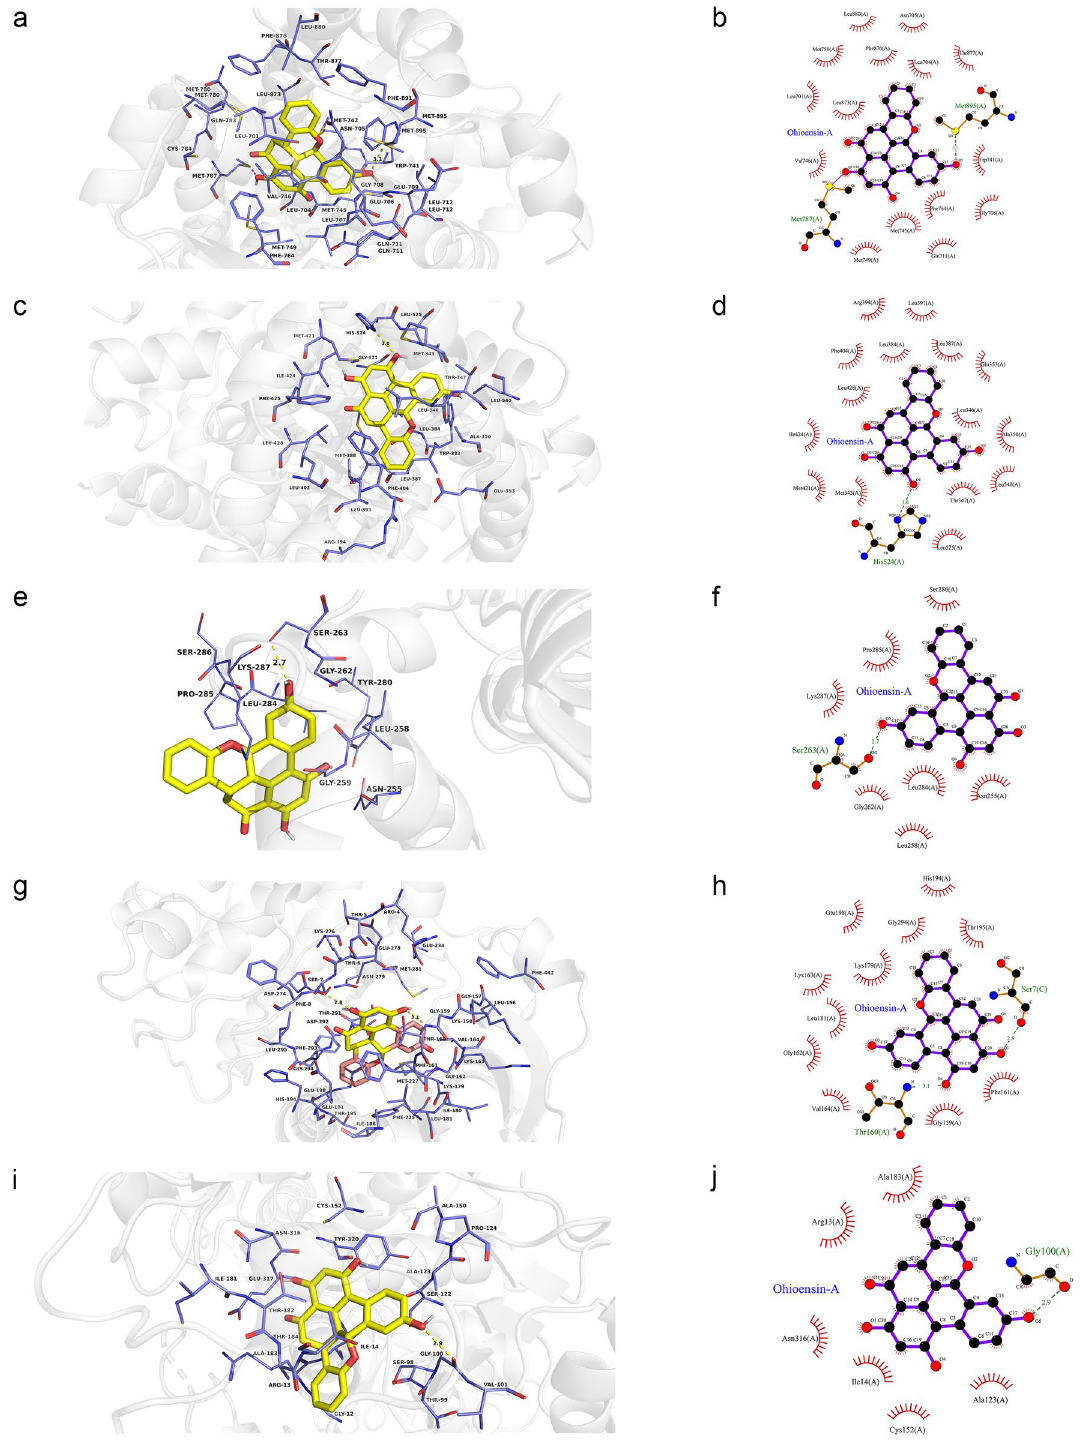
Figure 11. Molecular models of the binding of Ohioensin-A from MO to the predicted targets ( a , b ) AR, ( c , d ) ESR1, ( e , f ) MAPK3, ( g , h ) AKT1 and ( i , j ) GAPDH shown as 3D diagrams and 2D